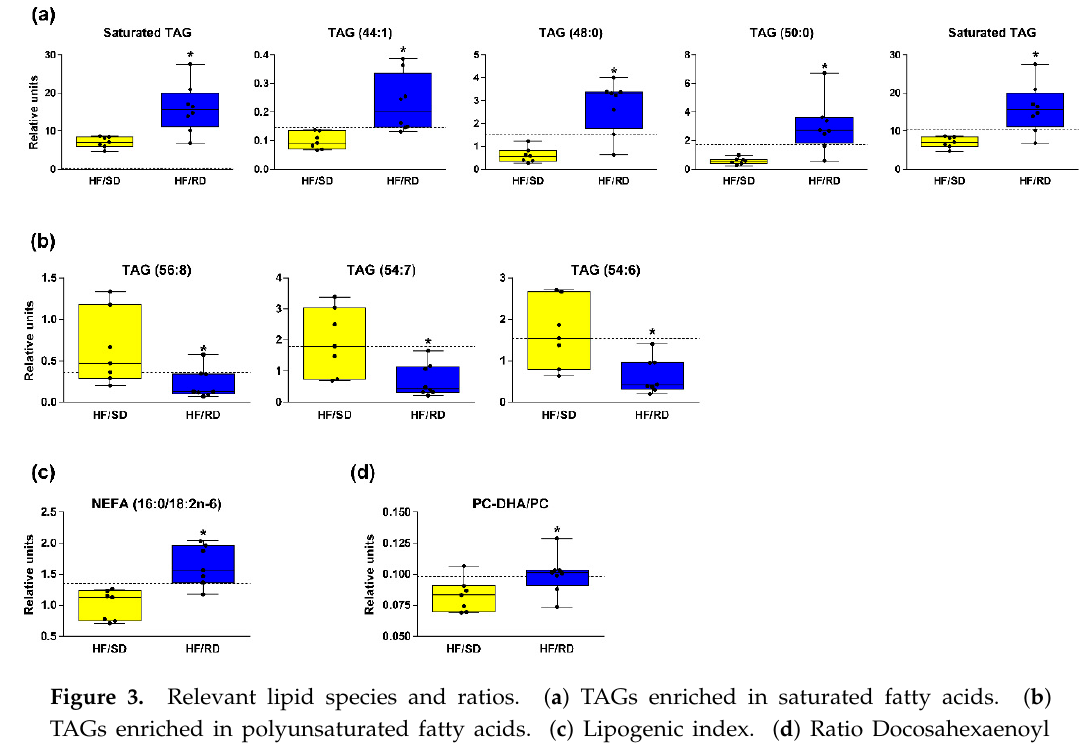
Figure 3. Relevant lipid species and ratios. ( a ) TAGs enriched in saturated fatty acids. ( b ) TAGs enriched in polyunsaturated fatty acids. ( c ) Lipogenic index. ( d ) Ratio Docosahexaenoyl Phosphatidylcholine / Phosphatidylcholine (PC–DHA / PC). The bar plots show the normalized values. The boxes range from 25%–75% percentiles; the 5% and 95% percentiles are indicated as error bars; single-data points are indicated by dots. Medians are indicated by horizontal lines within each box. Lines in all graphs show the reference group mean value. * p < 0.05 compared to the HF–SD group. NEFA, Non-esterified Fatyy Acids.